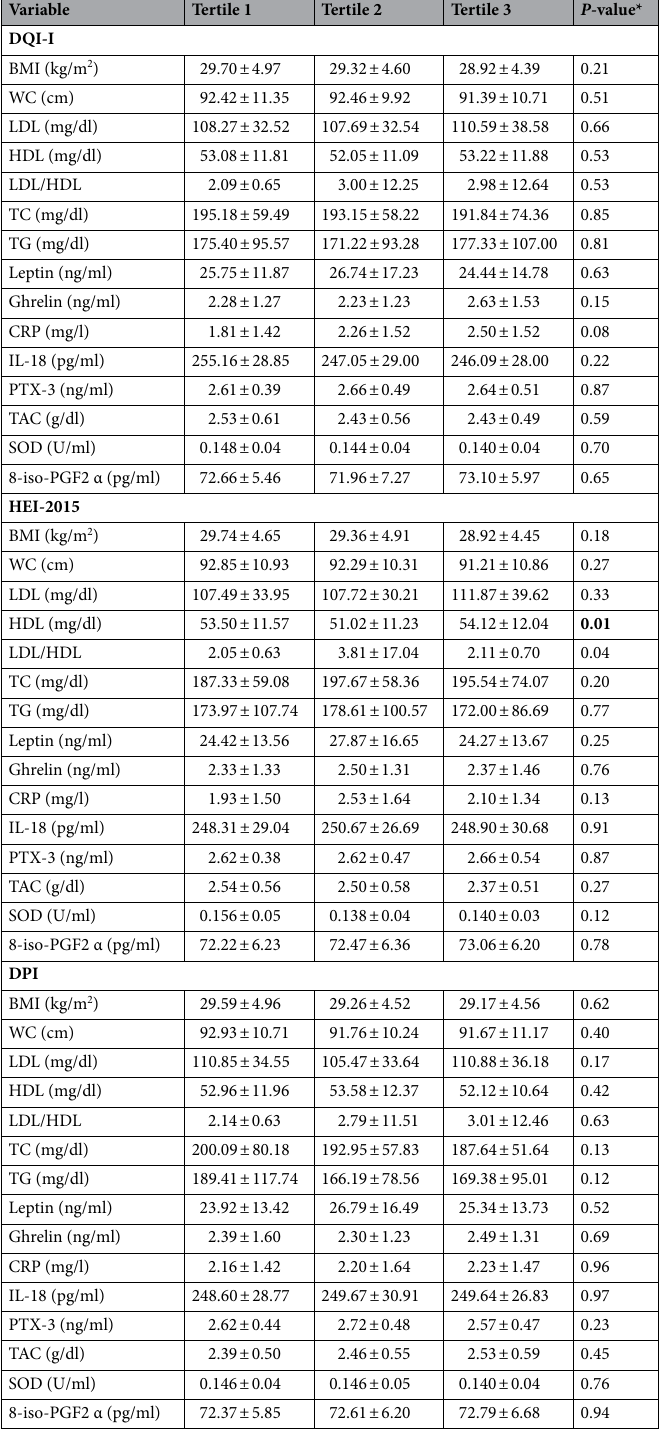
Table 1. Assessment of the associations of dietary quality index-international, healthy eating index-2015 and dietary phytochemical index with cardio metabolic parameters. P -value*: ANOVA models. DQI-I: